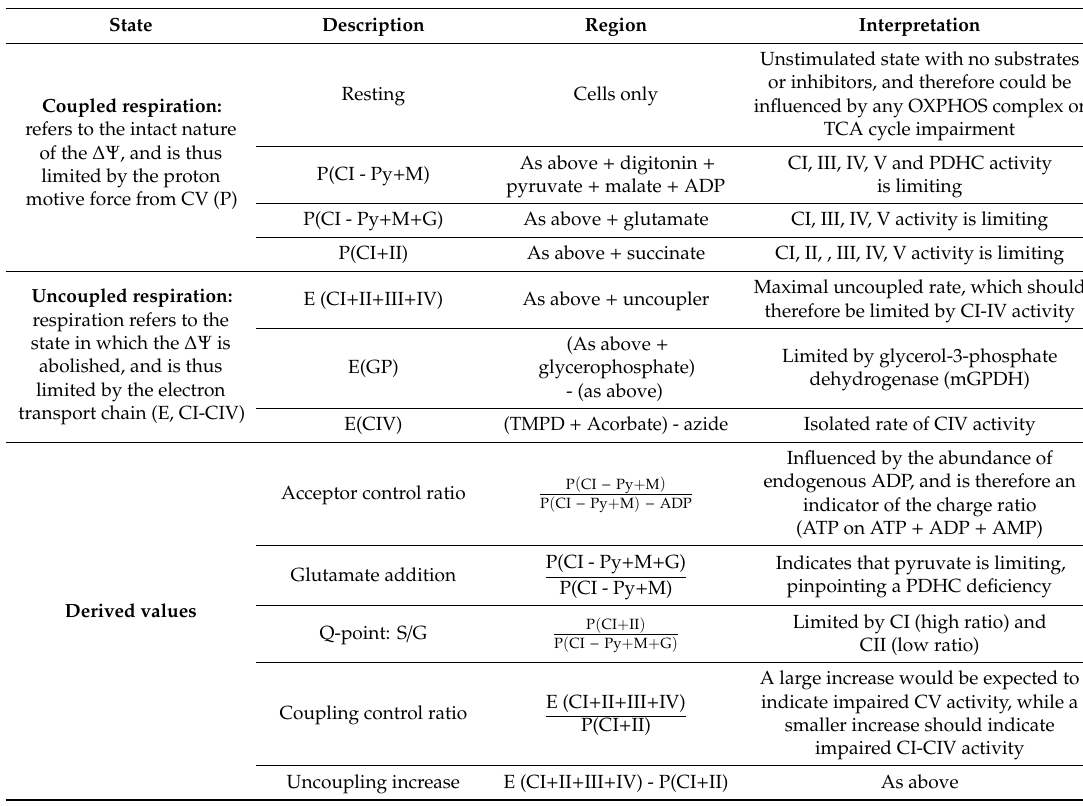
Table 4. A brief guide to the interpretation of the oxygraphy data. Abbreviations: ∆Ψ , mitochondrial membrane potential; CI–V, OXPHOS complexes I–V.